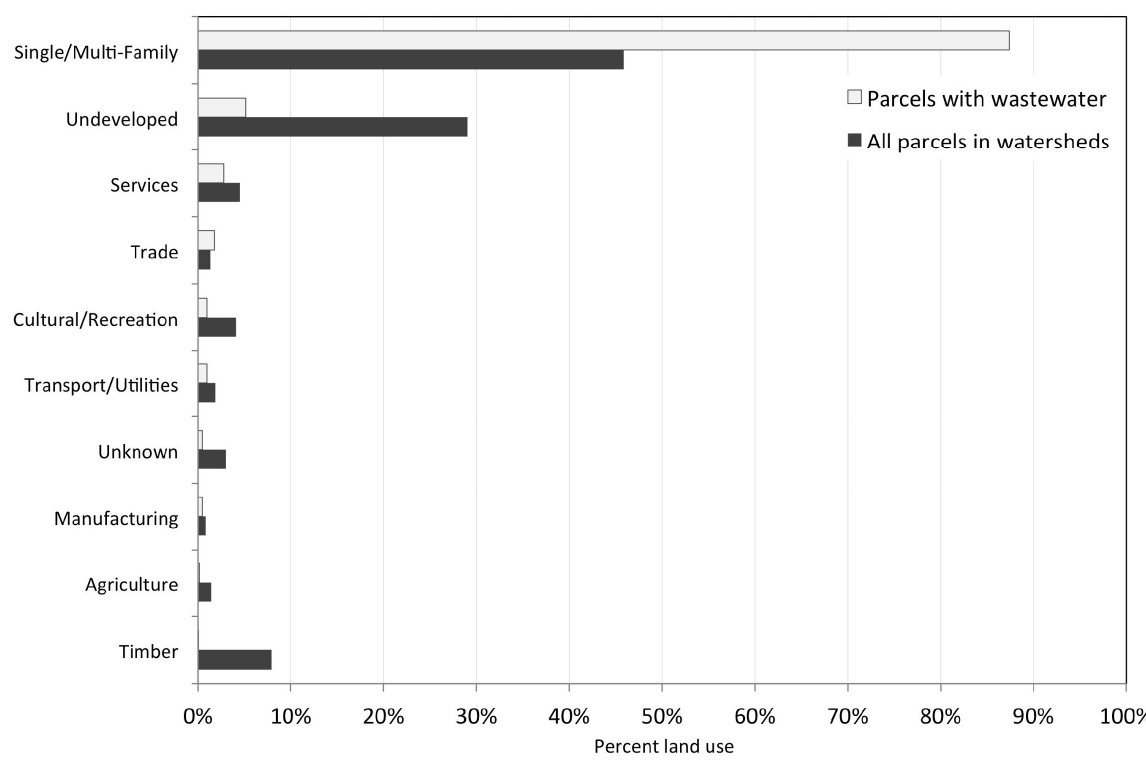
Figure 5. Proportion of land uses in parcels with wastewater treatment (septic or sewer) and the proportion of land uses in all parcels in sample watersheds. Over 87% of parcels with wastewater are single-family or multi-family